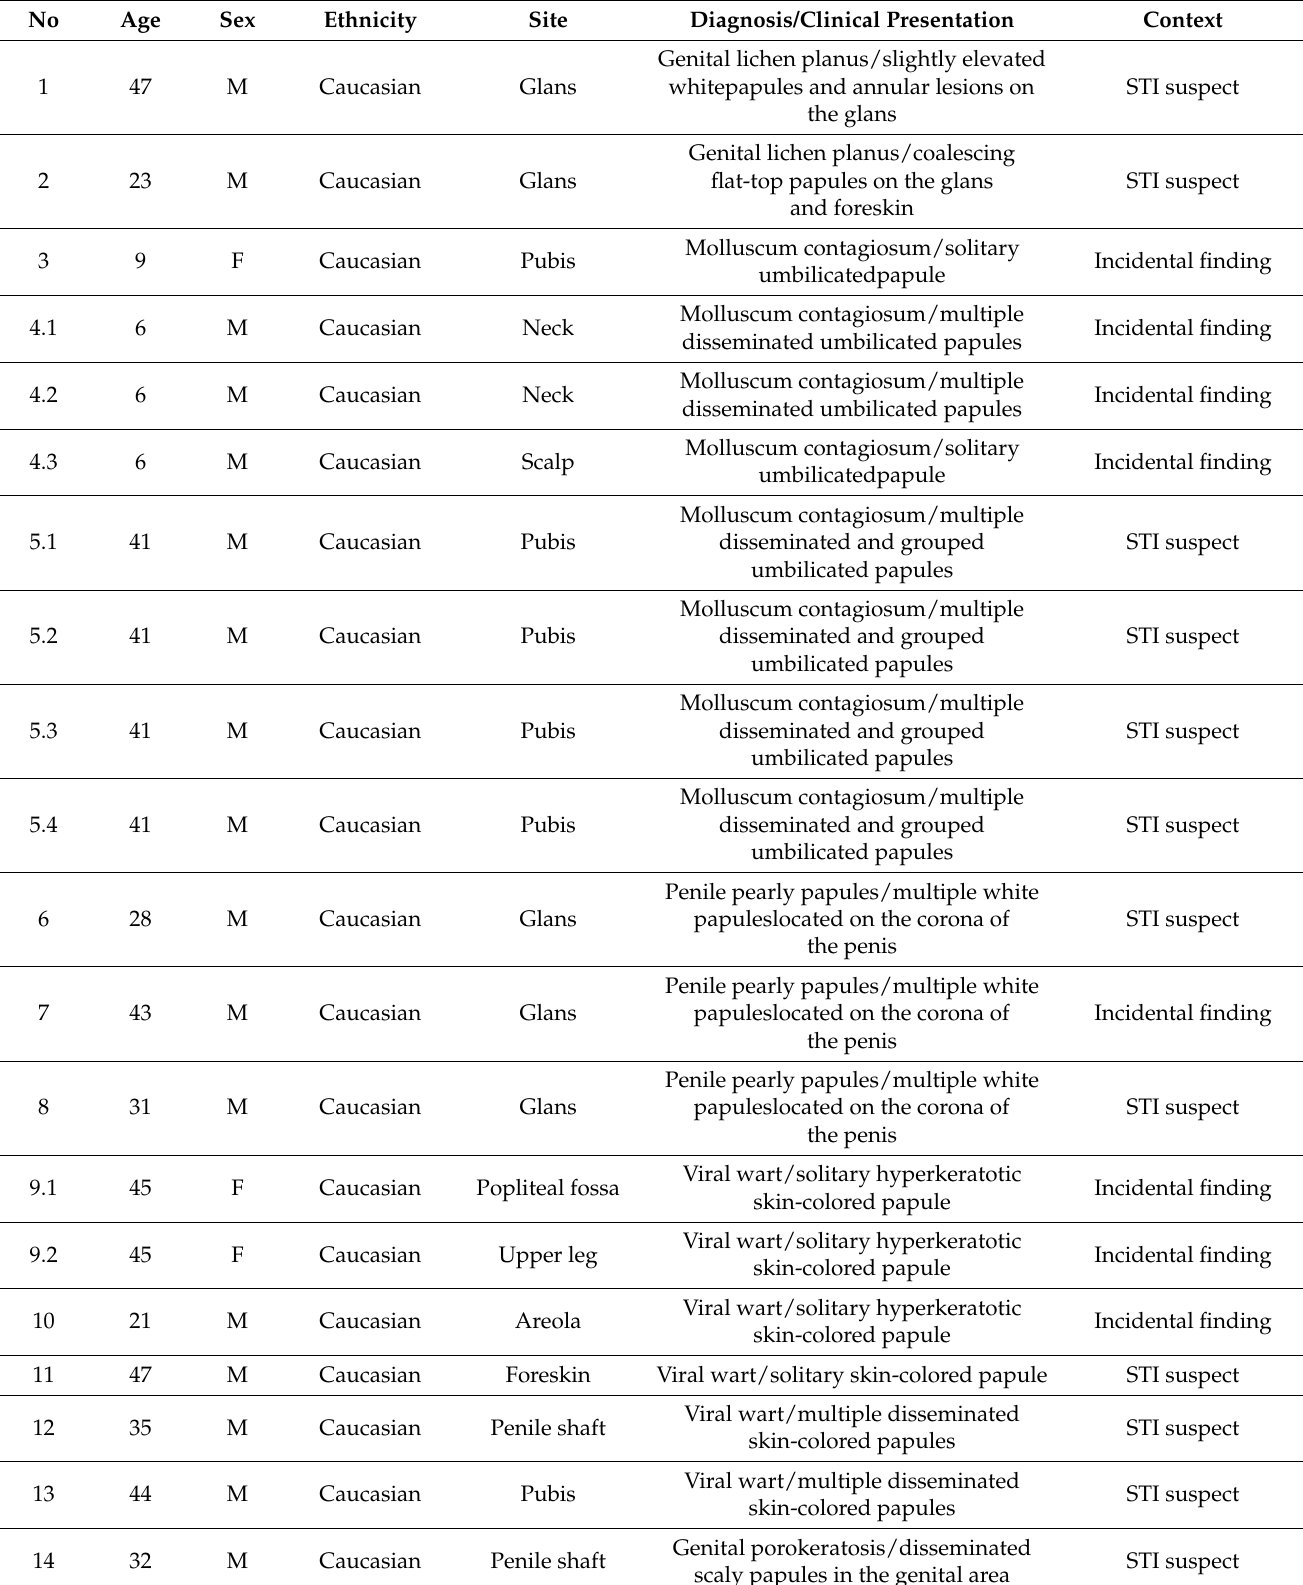
Table 2. Clinical characteristics of the control